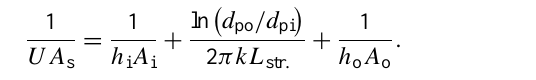
Figure A1. Temperature difference across the uncoiled